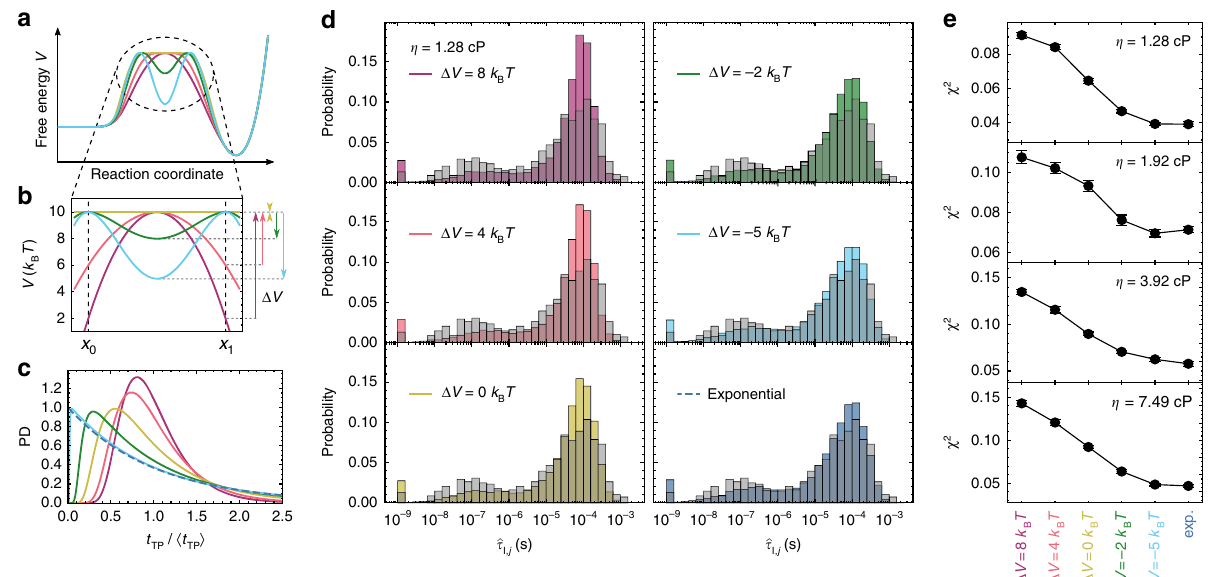
Fig. 3 Obtaining the shape of the barrier from transition path time distributions. a Schematic of free-energy surfaces with different barrier shapes. b Potentials used to calculate transition path time distributions, with the relevant barrier heights or stabilities of the intermediate indicated by the arrows to the right (same color code used in all panels). c Probability density (PD) functions of transition path times, t TP , calculated for the barrier shapes in ( b ), and an exponential t TP distribution (dashed). d Histogram of ^ τ I ; j for the measurement at 108 mM ionic strength without glycerol (gray), compared to histograms from simulated photon time traces based on different t TP distributions (colored, see legend). The smaller peaks in the sub-microsecond range are mostly due to transitions that were too fast to be accurately determined at the photon count rates of the corresponding time traces (see Methods and Supplementary Fig. 7). e χ 2 -distances between measured and simulated histograms for the measurements at different solvent viscosities, η (standard errors from 27 simulations